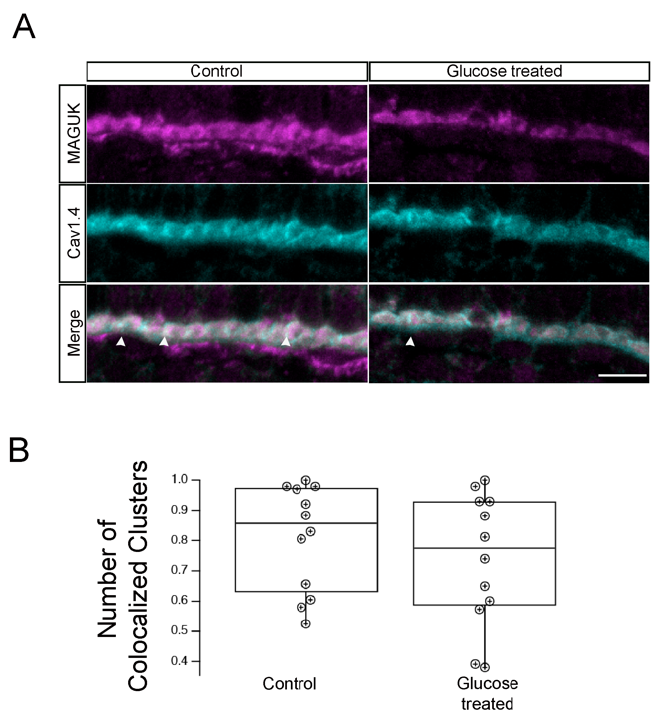
Figure 5. Hyperglycemic zebrafish larvae retained photoreceptor ribbon synapses with postsynaptic densities (PSDs) in INL dendrites. ( A )Transverse retinal cross-sections from 5 dpf control ( left panels ) or hyperglycemic ( right panels ) larvae were double immunostained with fluorescently labeled antibodies specific for the postsynaptic marker MAGUK (magenta, top ) or Cav1.4/cacna1f (cyan, middle ); overlays of MAGUK and Cav1.4 labeling are shown (merge, bottom ). Maximal intensity projections are shown; arrowheads indicate potential areas of colocalization. Scale bar, 5 µ m. ( B ) Quantitative analyses of IHC for MAGUK and Cav1,4 colocalization are indicted by box-and- whisker plots. Boxes indicate interquartile ranges, while whiskers indicate range of maximal and minimal values. Scale bar, 5 μ m. Abbreviations used: Cav1.4/cacna1f, voltage-dependent calcium channel; Dpf, days post-fertilization; INL, inner nuclear layer; MAGUK, membrane-associated guanylate kinase; PSD, postsynaptic densities; SEM, standard error of the mean.